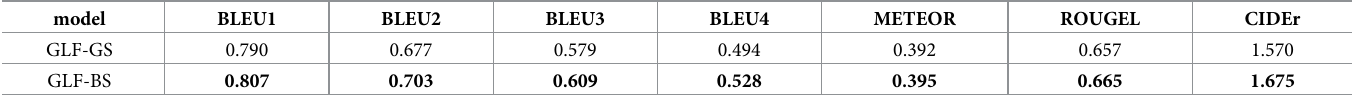
Table 5. Comparison of different search methods of GLF model.